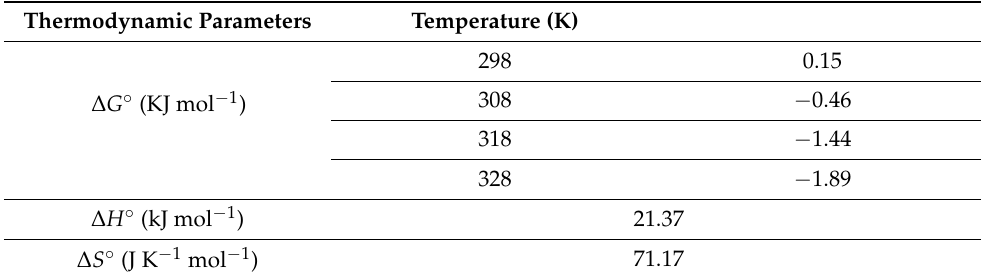
Figure 15. Adsorption thermodynamic of CR dye onto UCs. Table 8. Parameters of thermodynamic of adsorbing CR dye by UCs. Thermodynamic